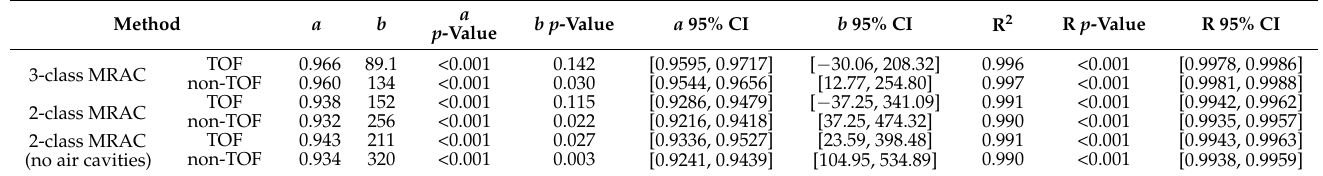
Table 1. Fitting coefficients a (slope) and b (intersect) for linear regression and R 2 values from the correlation analysis. Confidence intervals (CI) and p -values for regression and correlation coefficients are also presented. Coefficient b does not differ significantly from zero for 3-class MRAC TOF and 2-class MRAC TOF. Coefficient a and R 2 value are statistically significant for all